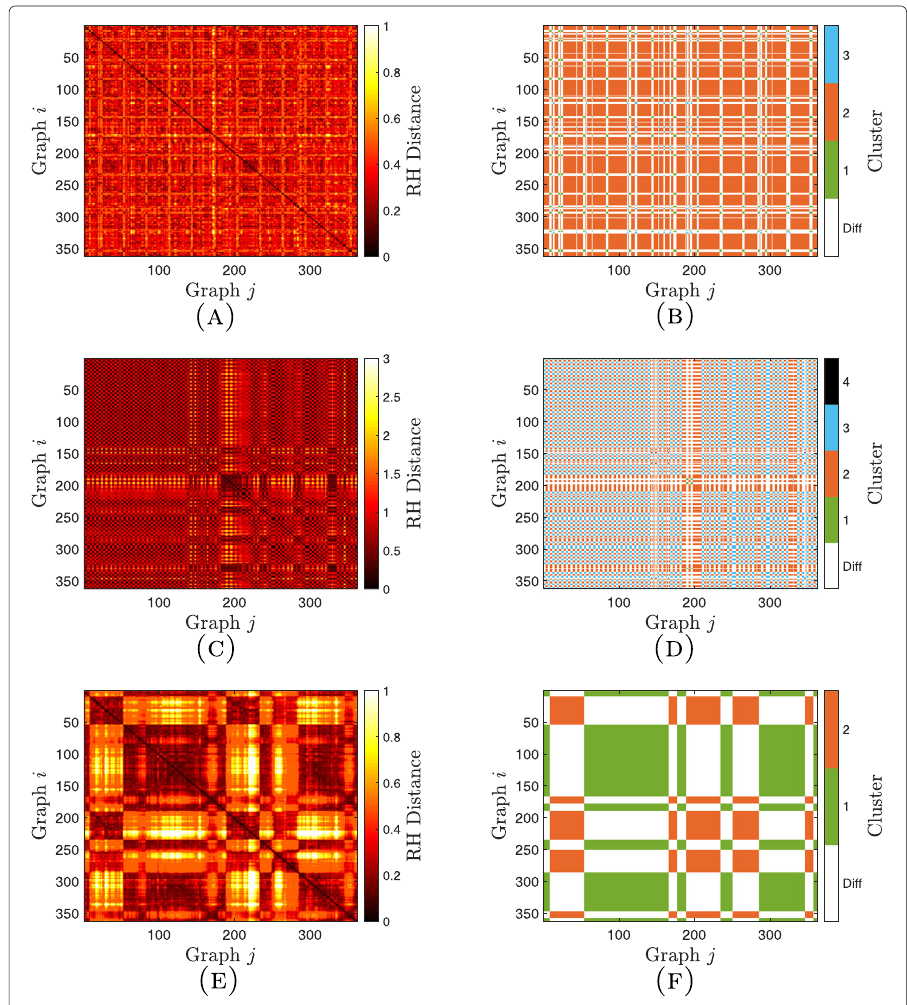
Fig. 2 LeftColumn: RH distance heatmaps for nominal two-hour period. RightColumn: Spectral clustering of similar graphs based on RH distances. a Authentication Heatmap. b Authentication Clustering. c Flow Heatmap. d Flow Clustering. e Process Heatmap. f Process